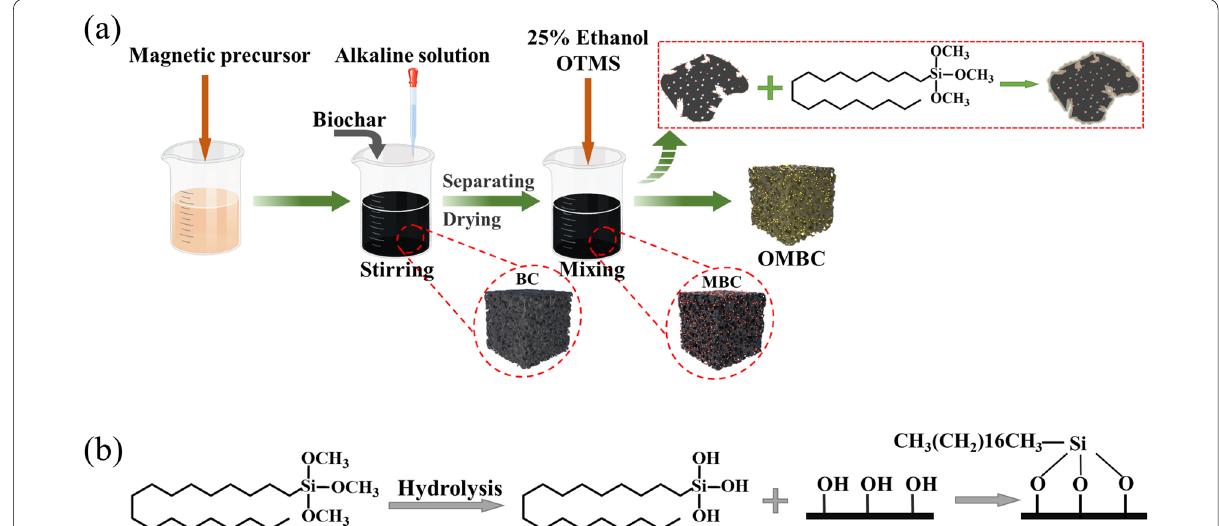
Fig. 1 General scheme for the preparation of the hydrophobic magnetic biochar ( a ). The schematic diagram of the silylation reaction mechanism for the magnetic biochar modification with OTMS ( b